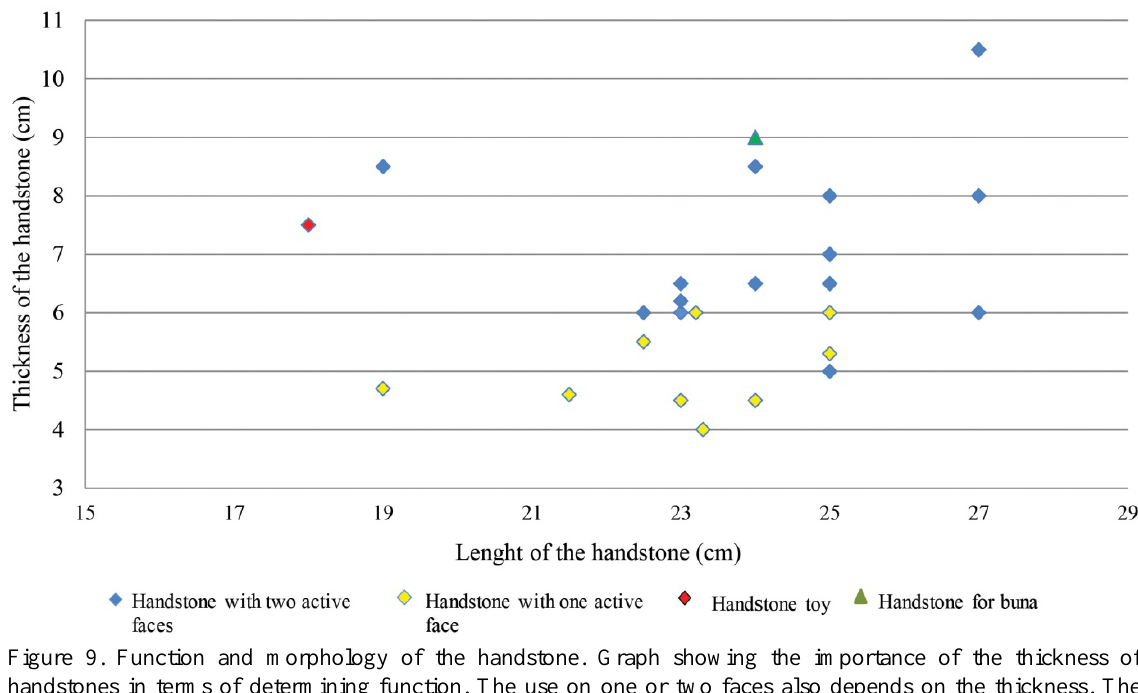
Figure 9. Function and morphology of the handstone. Graph showing the importance of the thickness of handstones in terms of determining function. The use on one or two faces also depends on the thickness. The length of the handstones is not a determining